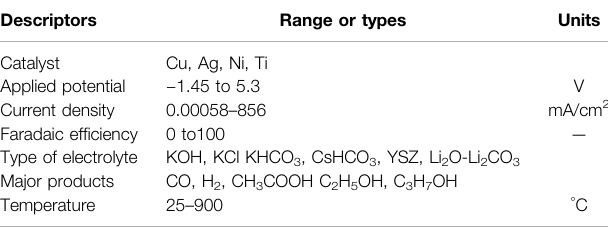
TABLE 1 | Key performance indicators and their types or range of values as being set in the data extraction